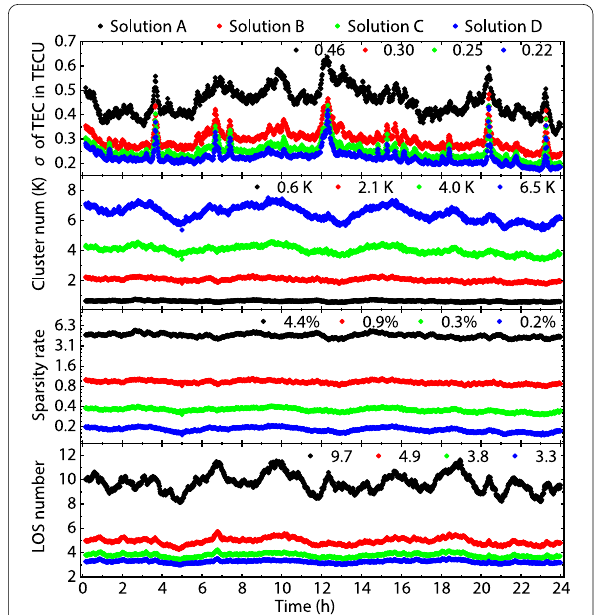
Fig. 9 Time series of σ , number of valid clusters, sparsity rate and number of LOS per cluster for different Q4DIM solutions on DOY 001, 2020